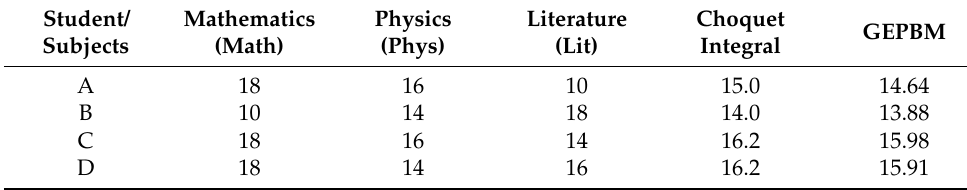
Table 1. Evaluation of the